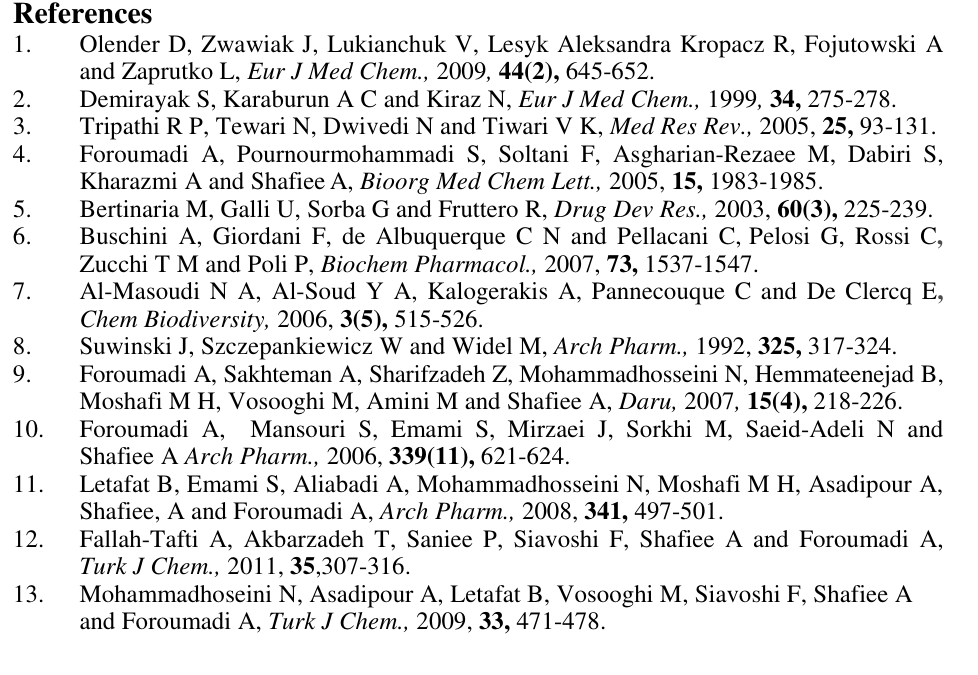
Gram negative bacteria Gram positive